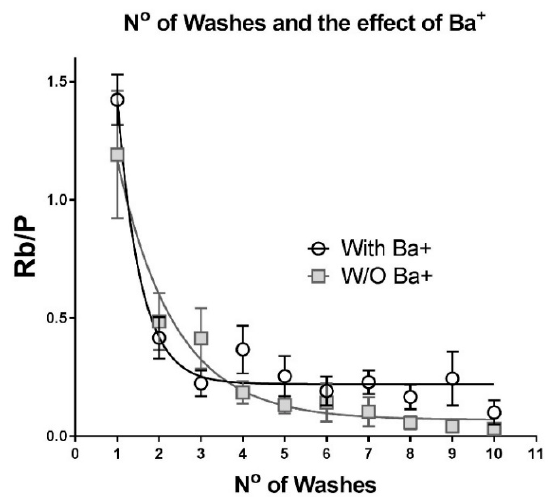
Figure 2. Residual Rb/P content in samples of dissociated fibers after 1–10 washes in a Rb + , Na + , and K + free wash solution at 0 C. Samples of 2–5 fibers were incubated for 4 min in Rb-containing uptake Buffer, then washed from 1–10 times for 1 min each in standard Wash Solution ( (cid:4) ), or Wash Solution containing 3 mM BaCl 2 ( ○ ). Error bars show the SEM for n = 5–8 samples at each wash.